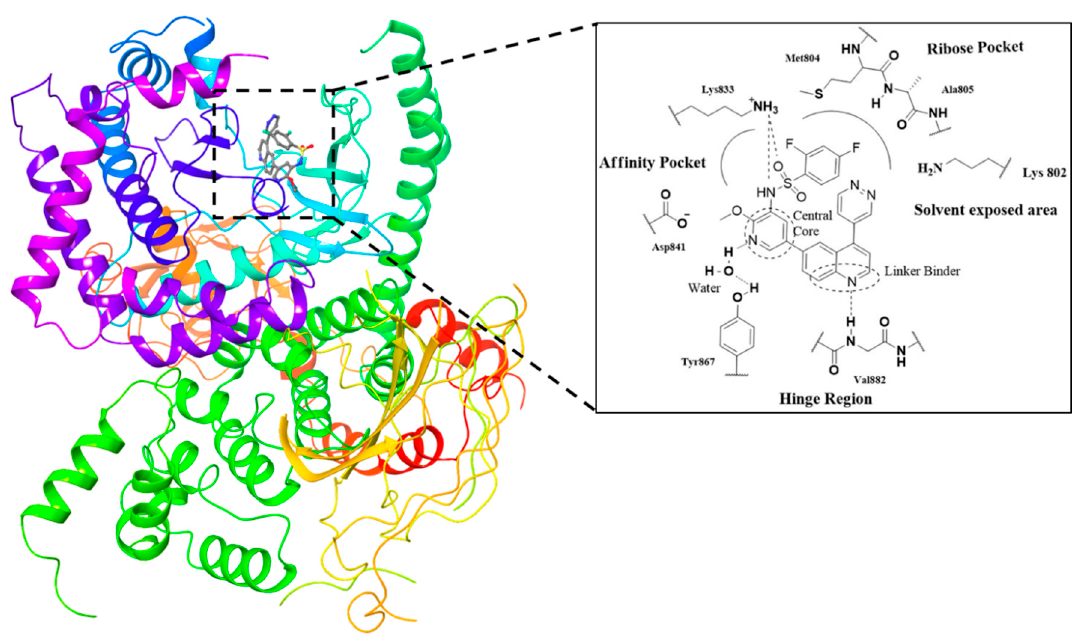
Figure 11. Crystal structure of omipalisib in complex with the catalytic subunit of PI3K γ (PDB id: 3L08) and detailed interactions [67,73].